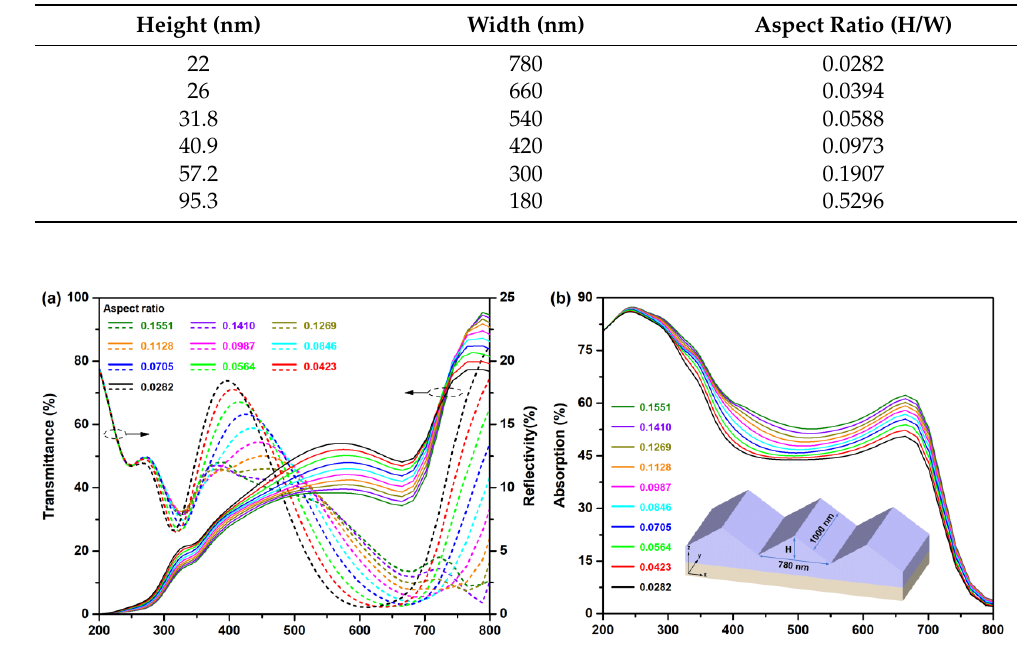
Table 1. Specific parameters for the equivalent SANR structures with different aspect ratios.